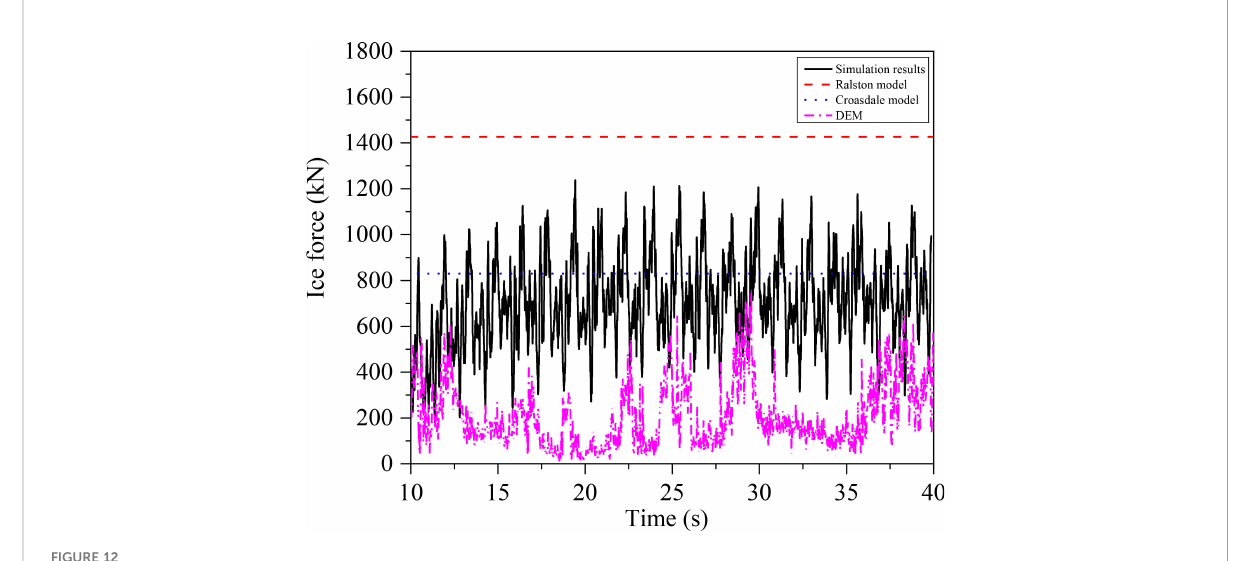
FIGURE 12 Comparison of dynamic ice load calculation with CEM, DEM, and static ice force